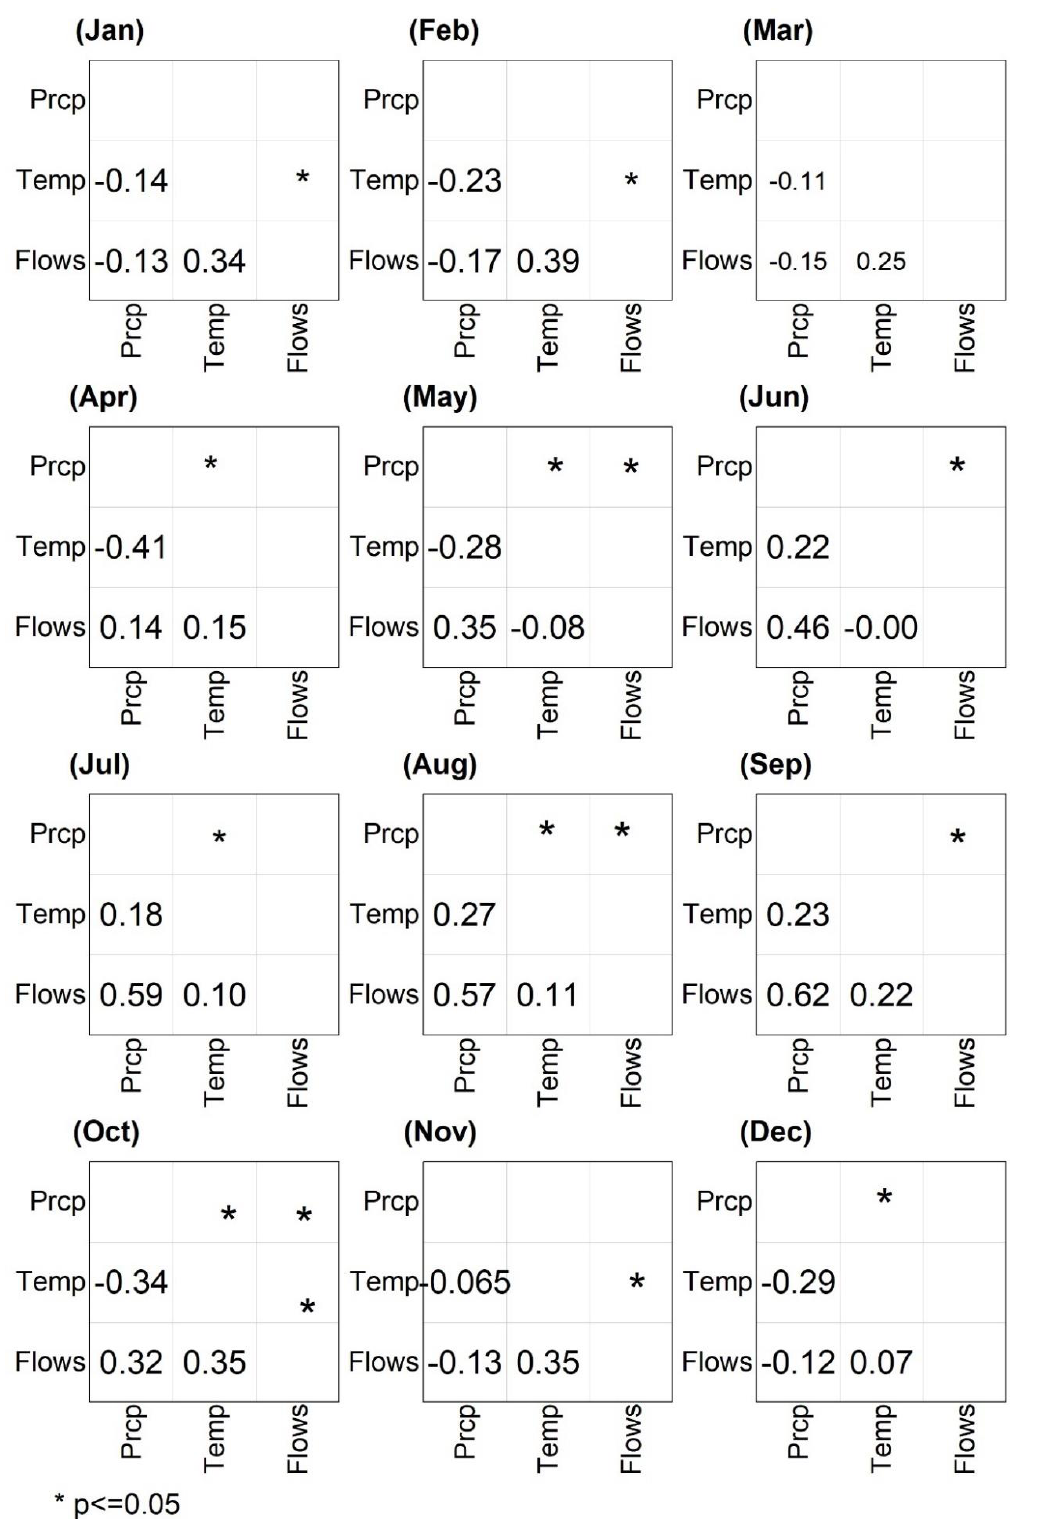
Figure 9. Monthly correlation plots of precipitation, temperature, and streamflow during 1961–2016 in the Yangtze River Source Region. The asterisk (*) sign shows the significance at 95% confidence level ( p <